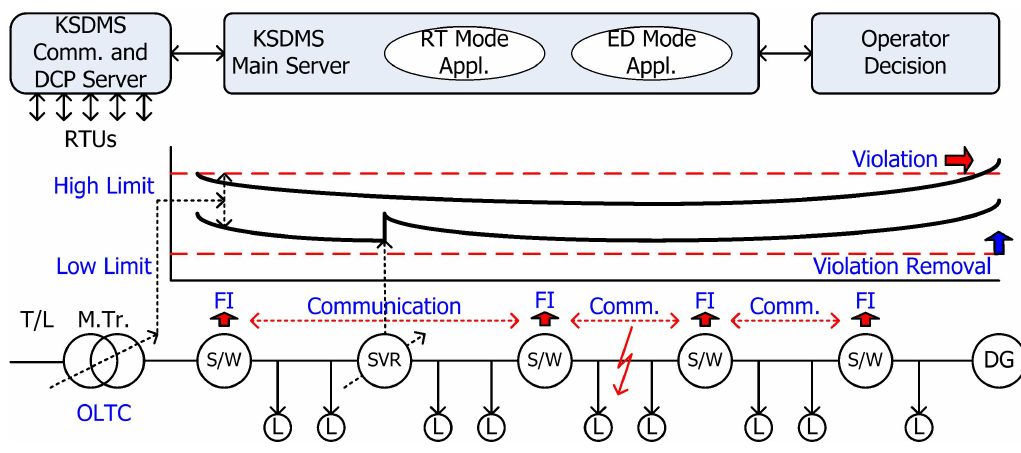
Figure 2. Concept of active distribution network.